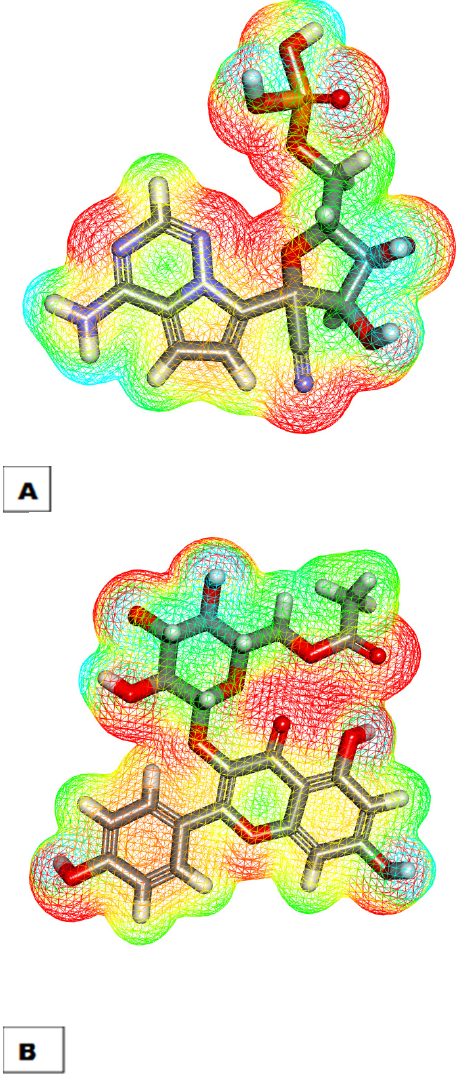
Figure 6. Molecular electrostatic potential maps of remdesivir ( A ) and K3G-A ( B ).